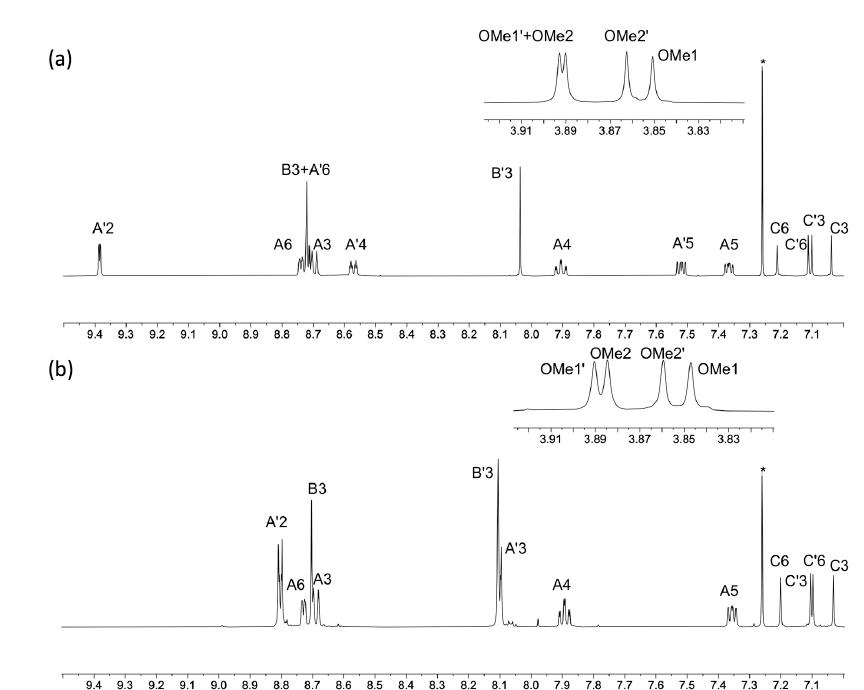
Figure 6. A comparison of the aromatic regions of the 1 H NMR spectra of compounds ( a ) 5 and ( b ) 6 with the OMe region shown in the insets (500 MHz, CDCl 3 , 298 K). * = residual CHCl 3 . For